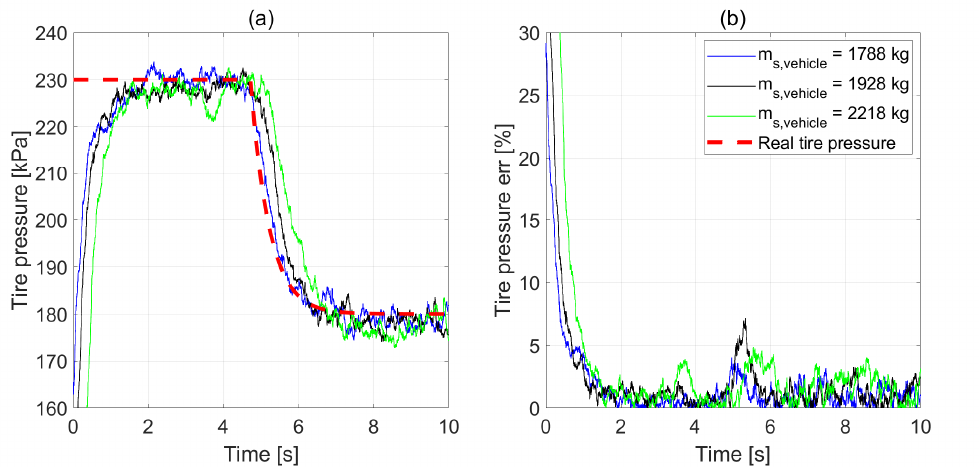
Figure 11. ( a ) Estimation of tire pressure with respect to different total sprung mass of the vehicle m s , vehicle and ( b ) estimation errors.